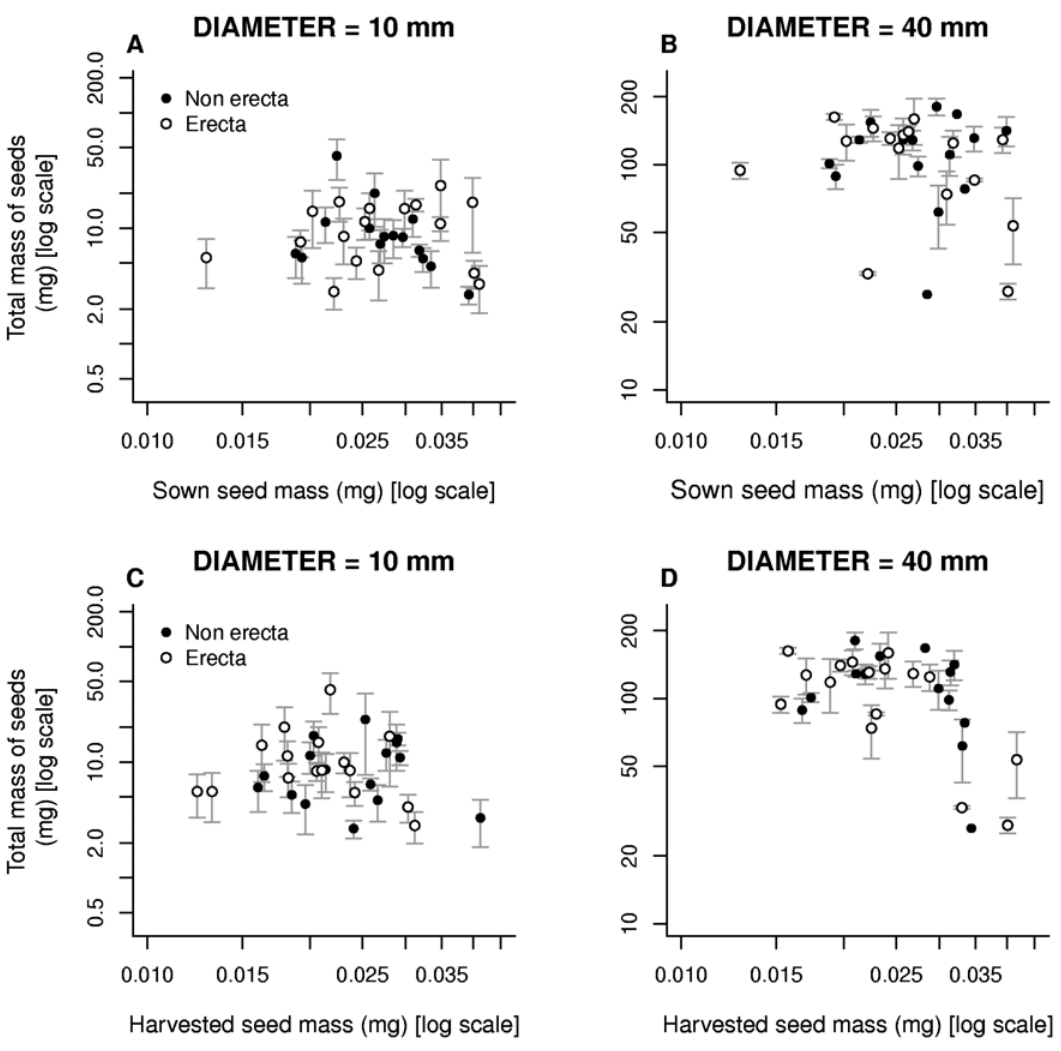
Figure 4. The relationship between the total mass of seeds produced and both sown seed mass and harvested seed mass. Points show the mean ( 6 1 s.e.m) of all individuals belonging to the same line.